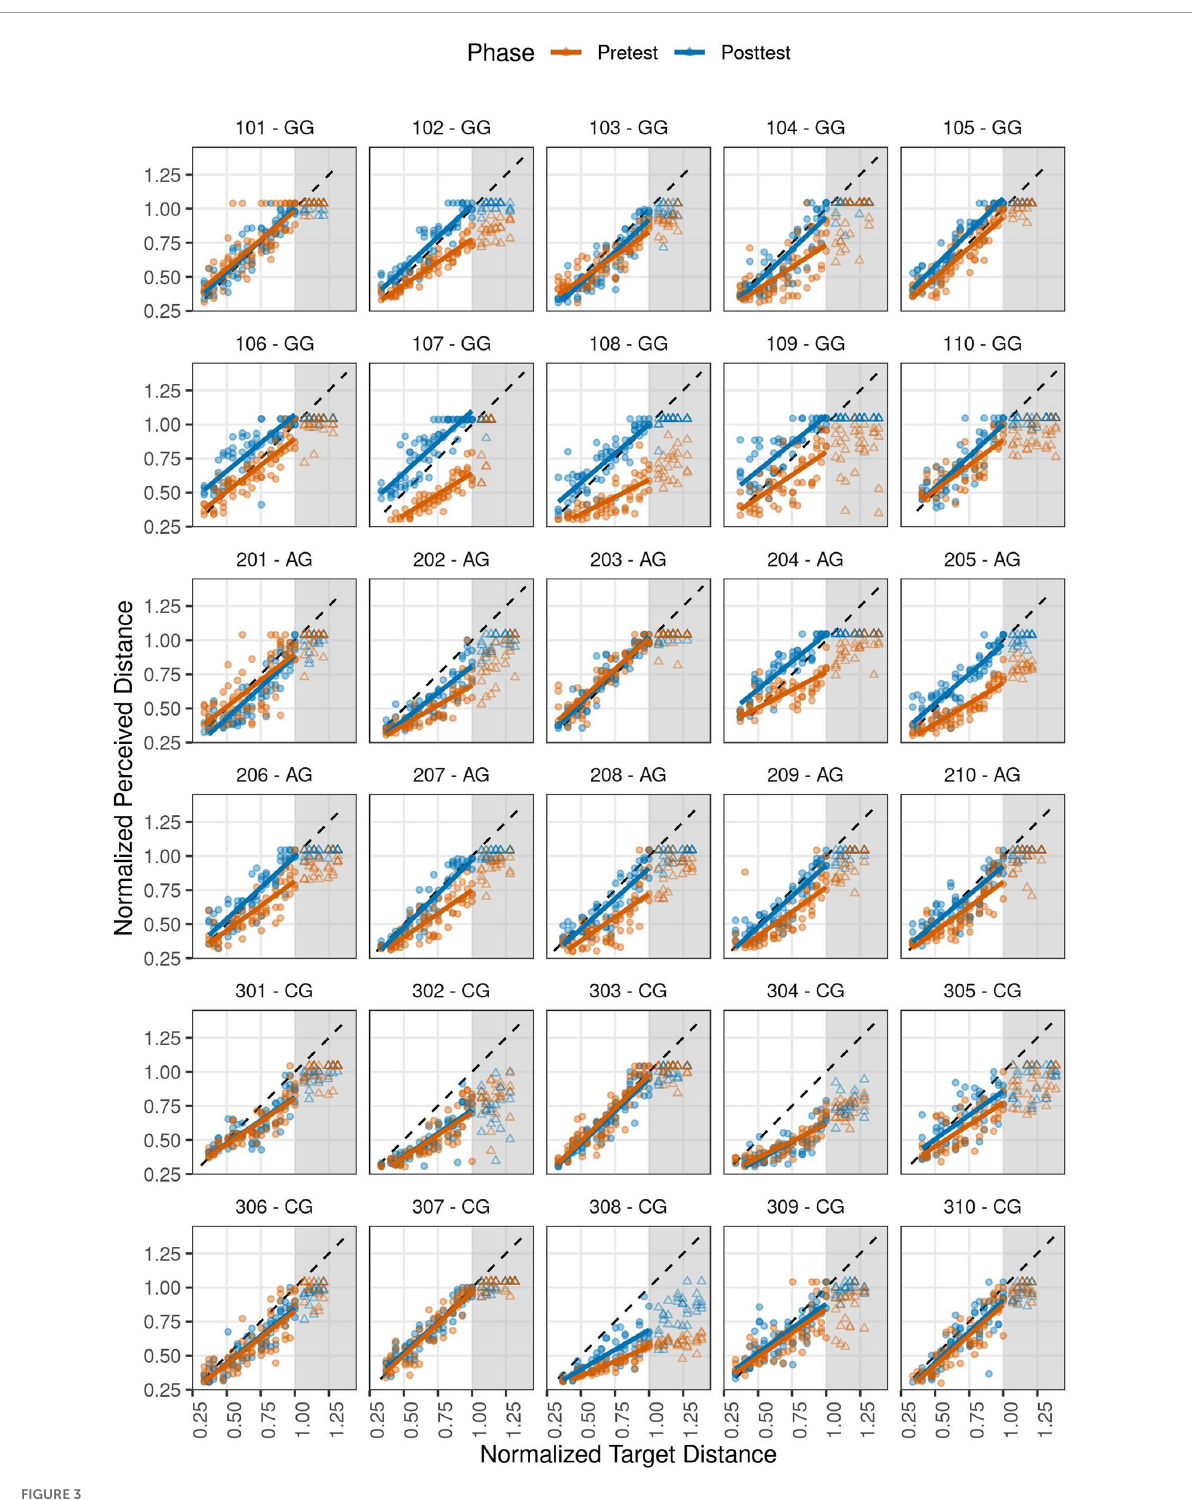
FIGURE3 Perceived auditory distance for each participant according to each group and phase. Participants 101–110 corresponds to GG, 201–210 to AG, and 301–310 to CG. X -axis represents Normalized Target Distance (in MRD units) and y -axis the Normalized Perceived Distance (also in MRD units). The distance judgments for each trial are shown by dots for reachable target distances and by triangles for the unreachable ones. The solid lines represent the prediction of the fitted model (for reachable targets up to 1.0 MRD). Gray area indicates the unreachable zone and diagonal dashed lines the ideal